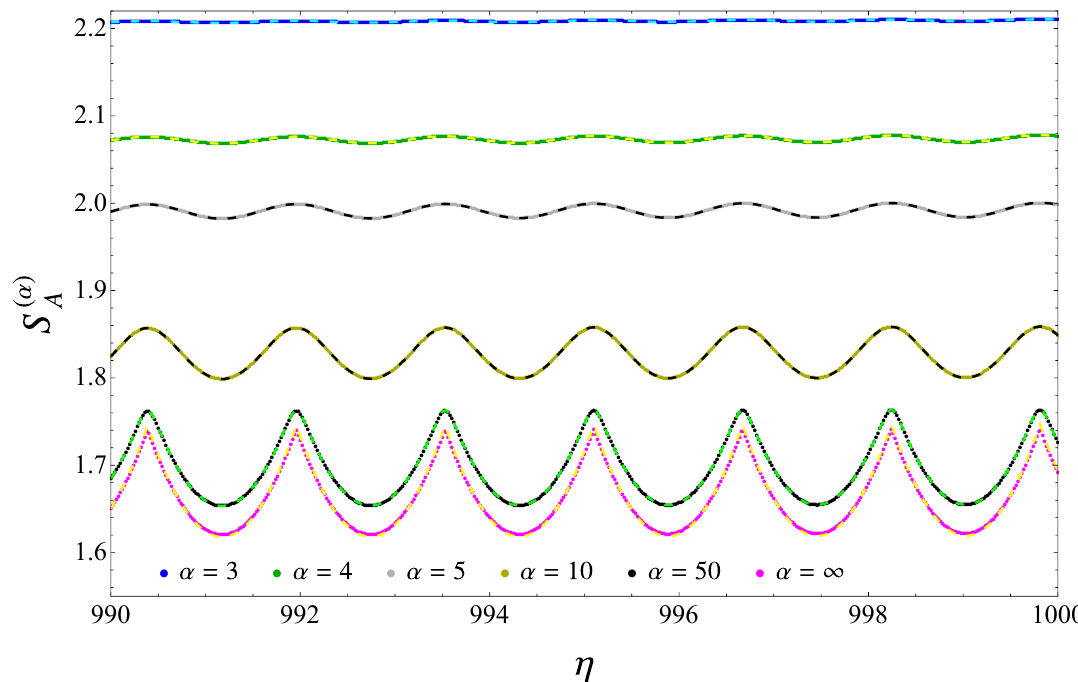
Figure 9. Oscillatory behaviour of the entanglement entropies with α > 1 in the regime of large η . The dashed curves are obtained from (8.15), (8.17) and